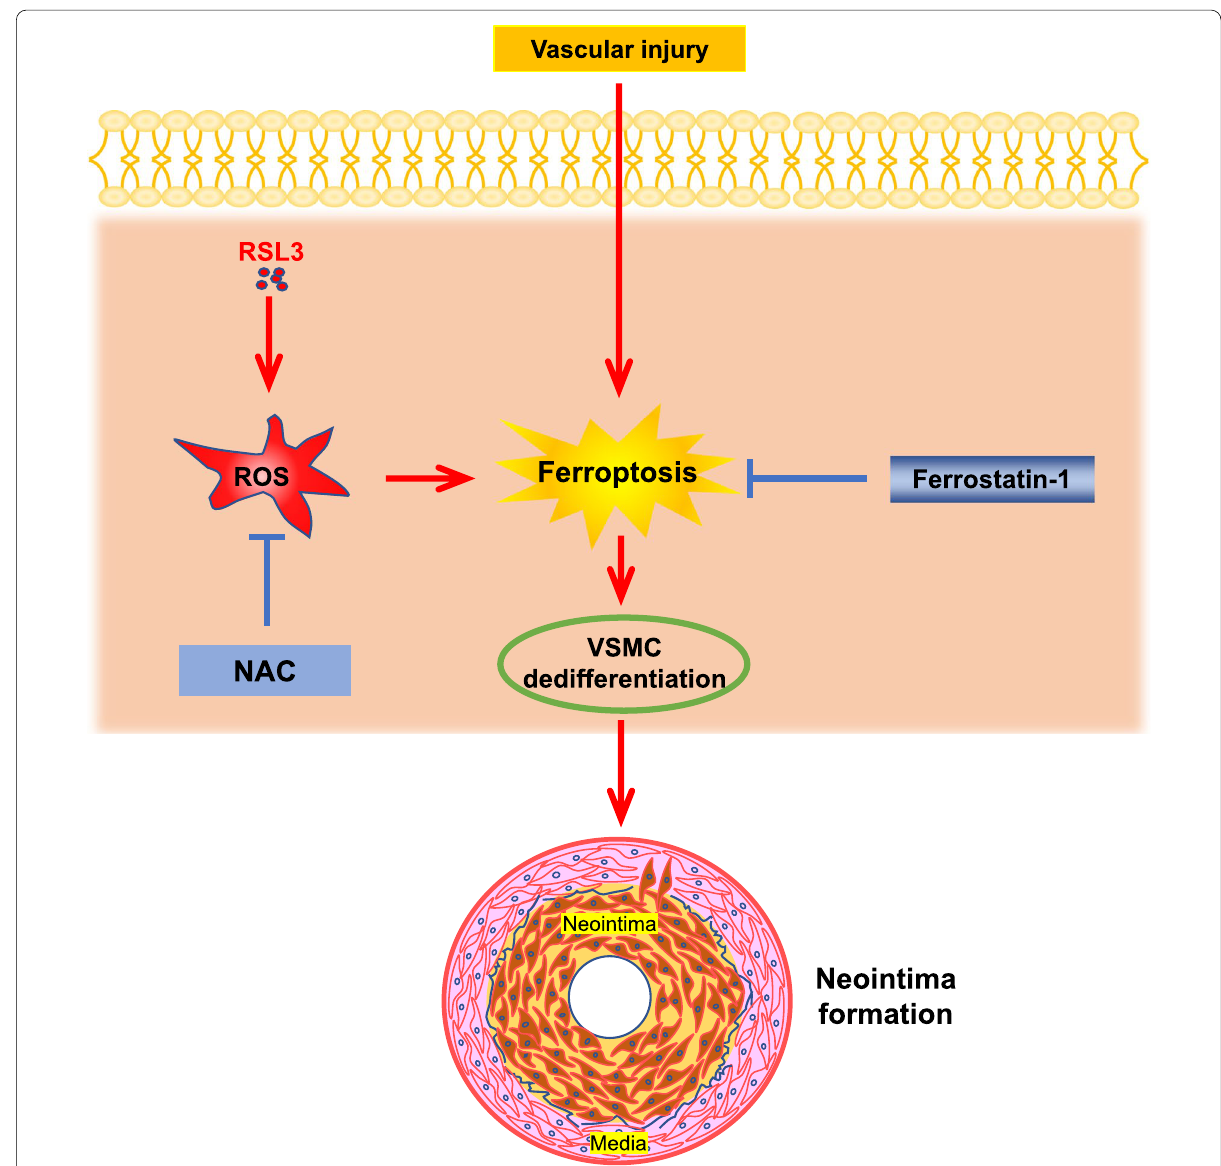
Fig. 7 A schematic model showing that ferroptosis promotes VSMC phenotypic switching in a ROS‑dependent manner and consequently aggravates mouse ligation‑induced neointimal formation of carotid